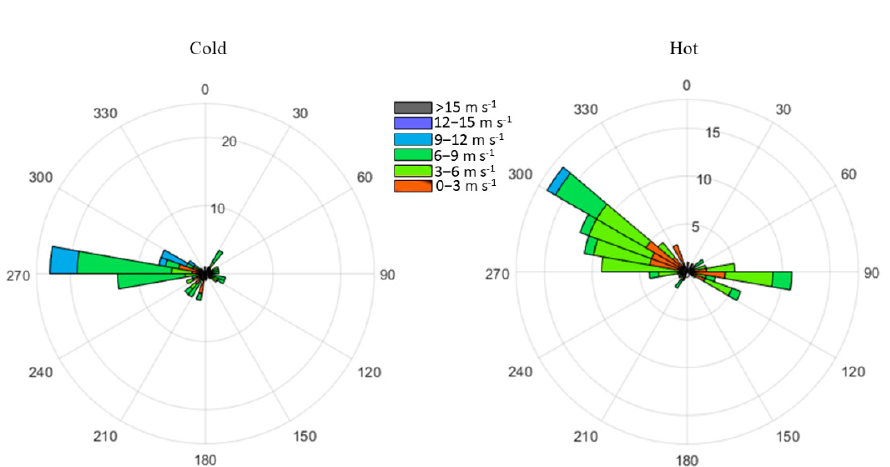
Figure 3. Wind roses representing velocity and direction of sustained wind for hour of maximum PM 10 concentration at TCEQ site CAMS-12, El Paso, Texas, on dust exposure dates defined by PM 10 during 2010–2014. Cold season ( left ) includes October through March; hot season ( right ) includes April through September.